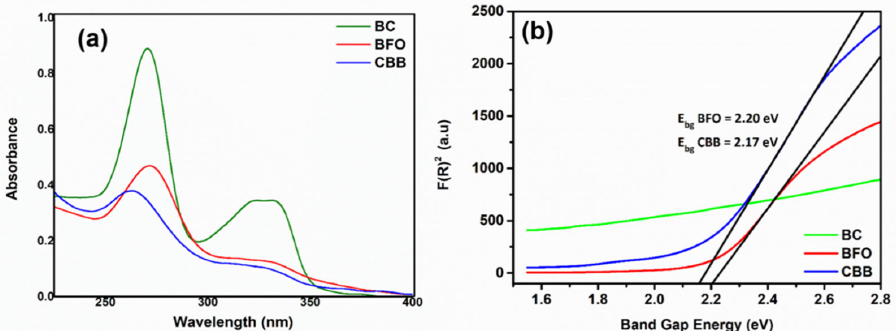
Figure 3. ( a ) Diffuse reflectance spectra of the samples and ( b ) determination of the band gap energy by the Kubelka–Munk